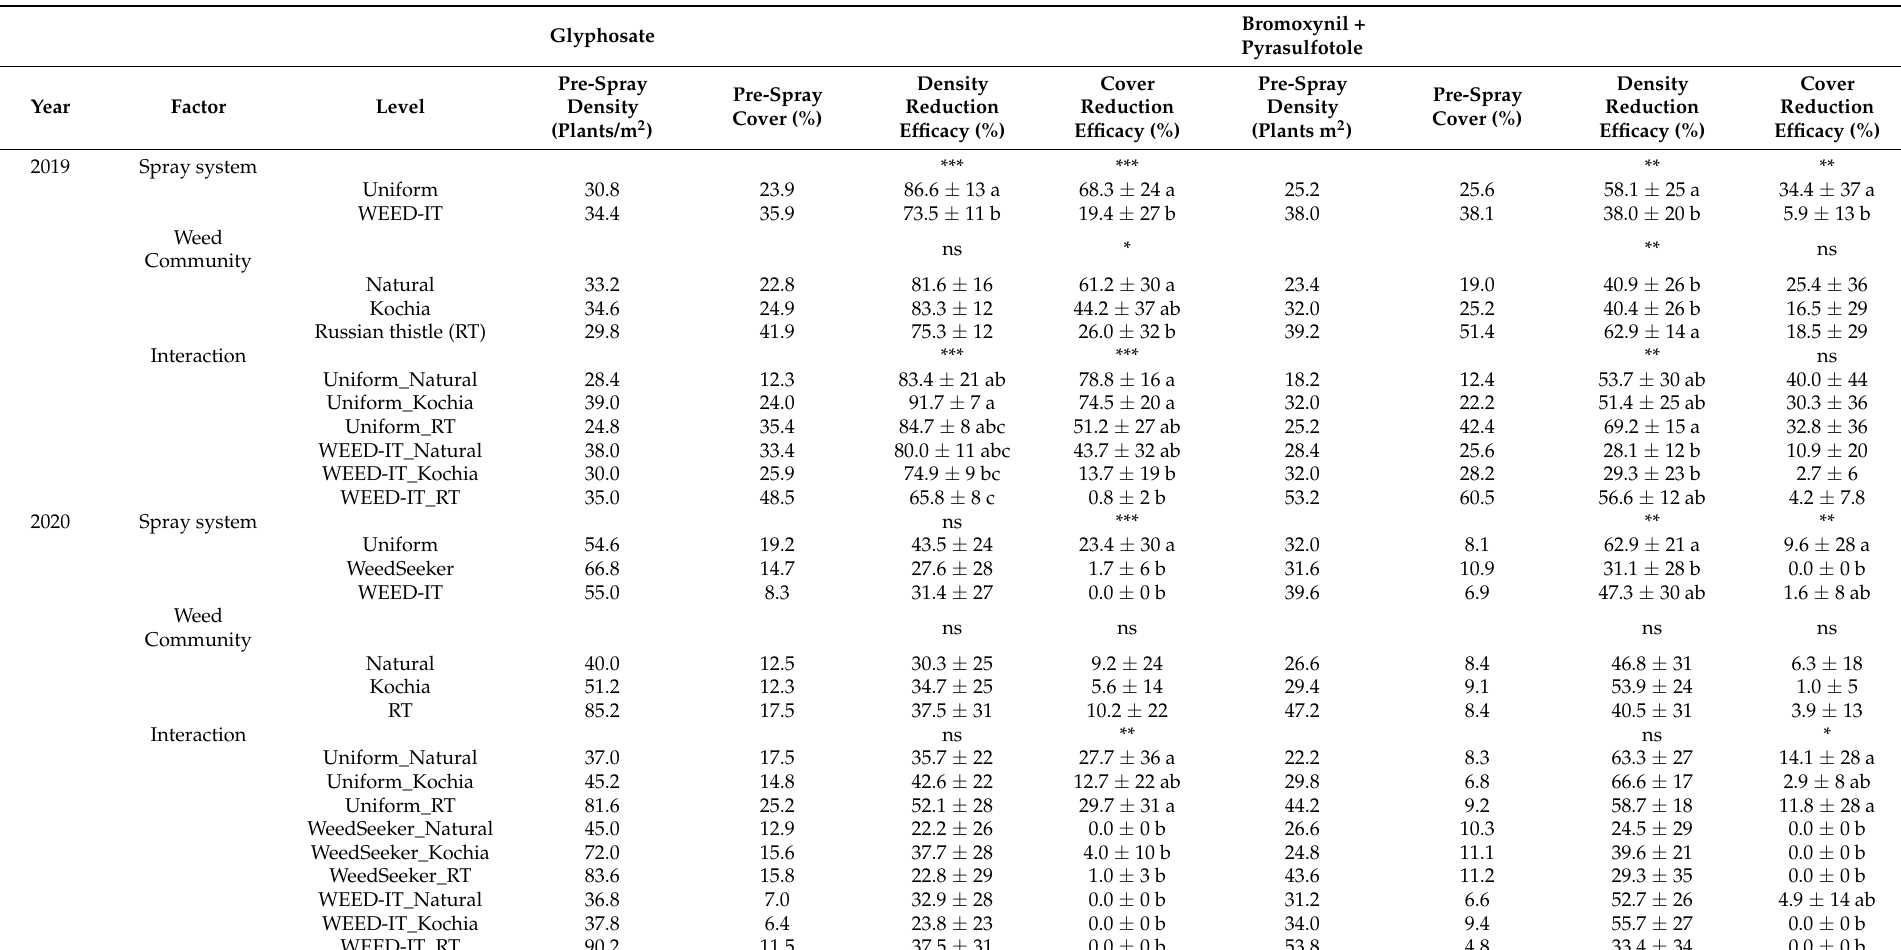
Table 2. Pre-spray weed density and cover, and herbicide control efficacy (mean ± SD) for plant density and cover in the fallow trial for glyphosate and bromoxynil + pyrasulfotole herbicides in 2019 and